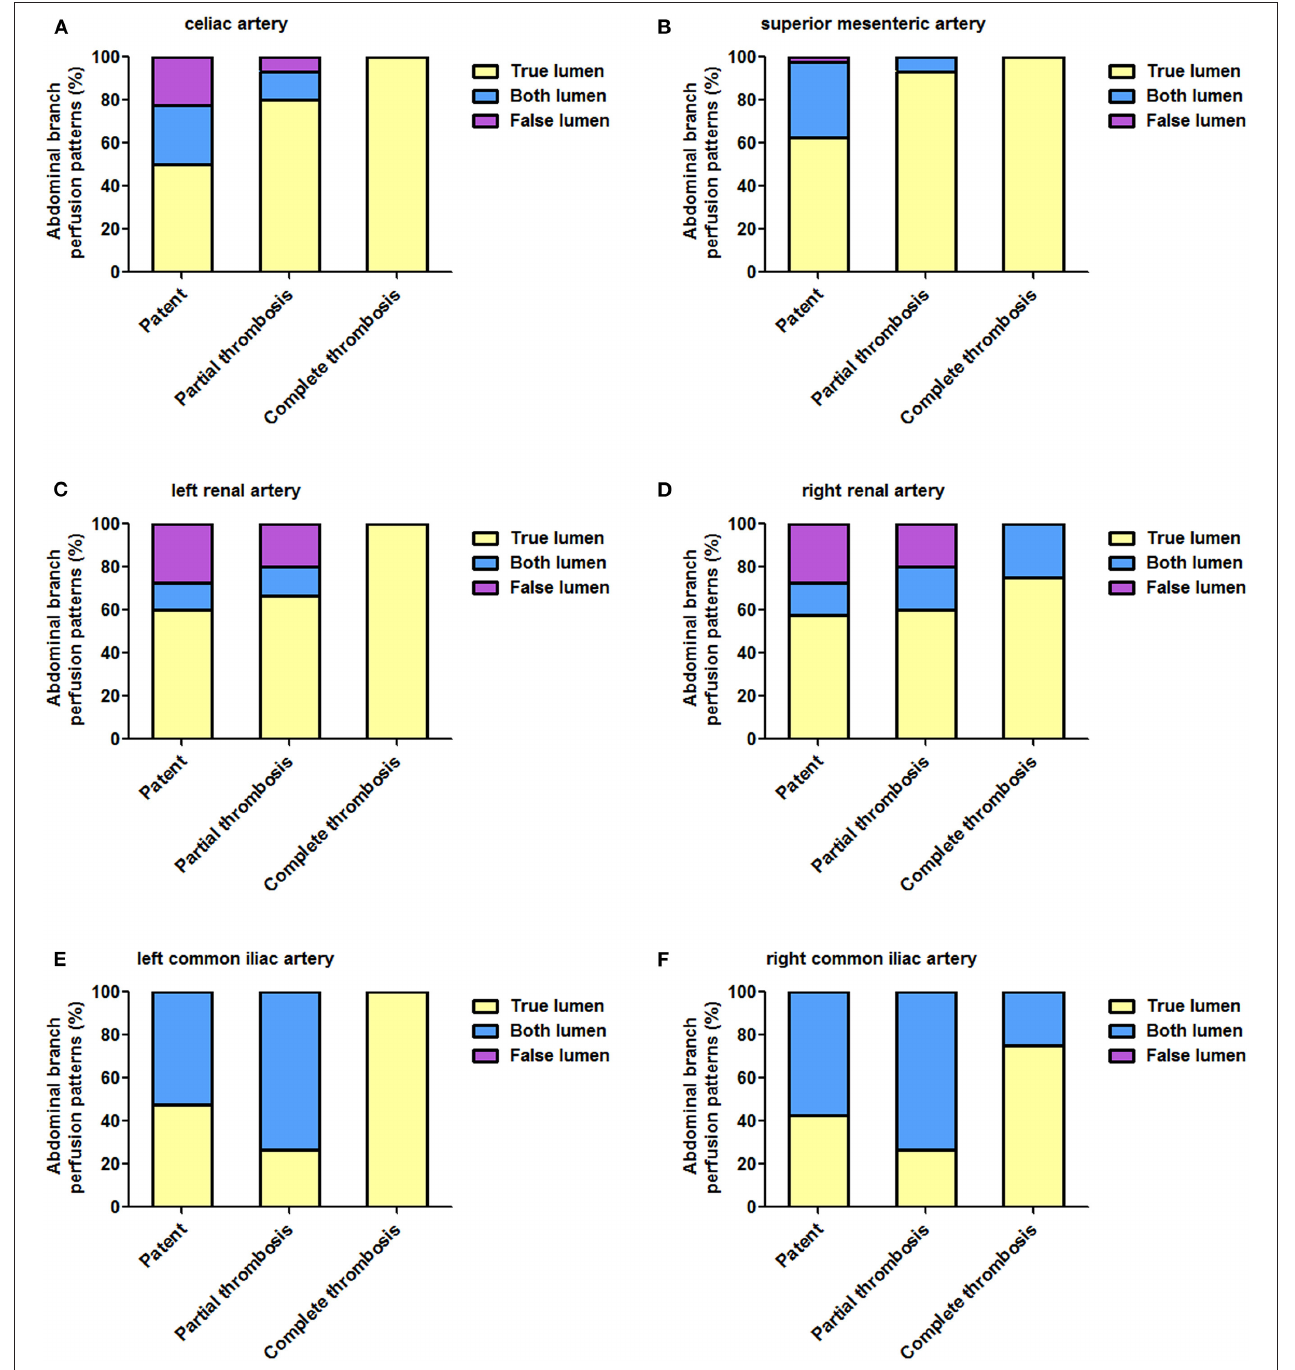
FIGURE 7 | Abdominal aortic branch perfusion patterns according to FL status during follow-up. (A–E) The percentage of TL perfusion on all abdominal branches was higher in patients with completely thrombosed FL than in patients with patent or partially thrombosed FL, and this difference reached a statistical significance on celiac (A) , superior mesenteric (B) , and left common iliac (E) arteries. FL, false lumen; TL, true lumen.